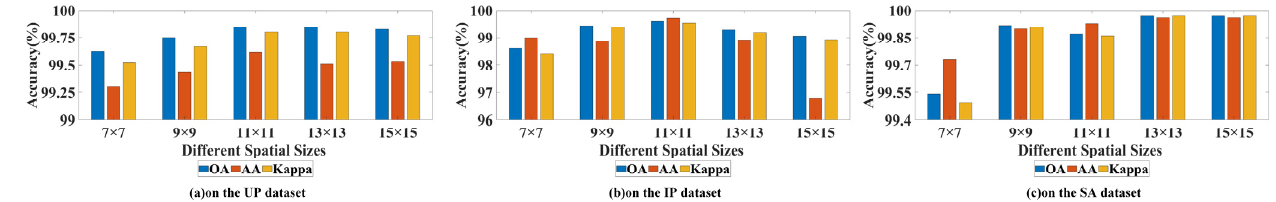
Figure 6. The effect of spatial sizes.